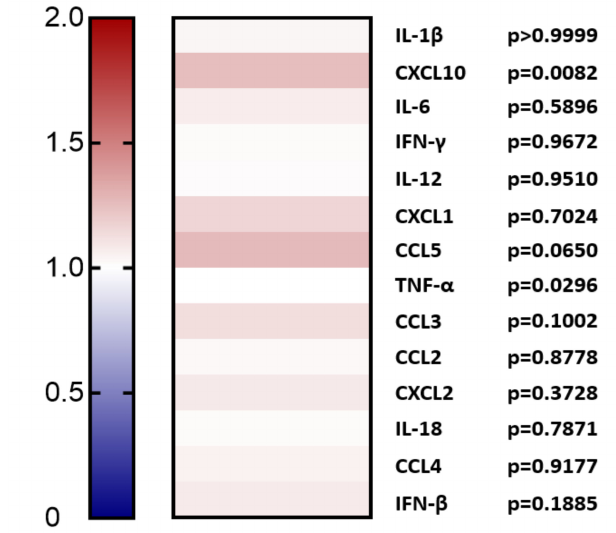
Figure 4. Heat map analysis of the expression of cytokines in the plasma of mice over-expressing PCSK9 in vivo in comparison to control mice. The expression of inflammatory cytokines was measured using the Luminex assay in the plasma of the PCSK9 over-expressing mice ( n = 8) and compared to the control mice ( n = 8). Data are represented in the form of fold change for upregulated and downregulated cytokines with respect to the control mice. Mann–Whitney test was performed to analyze the disparities between the groups, and the groups with p < 0.05 were considered significantly